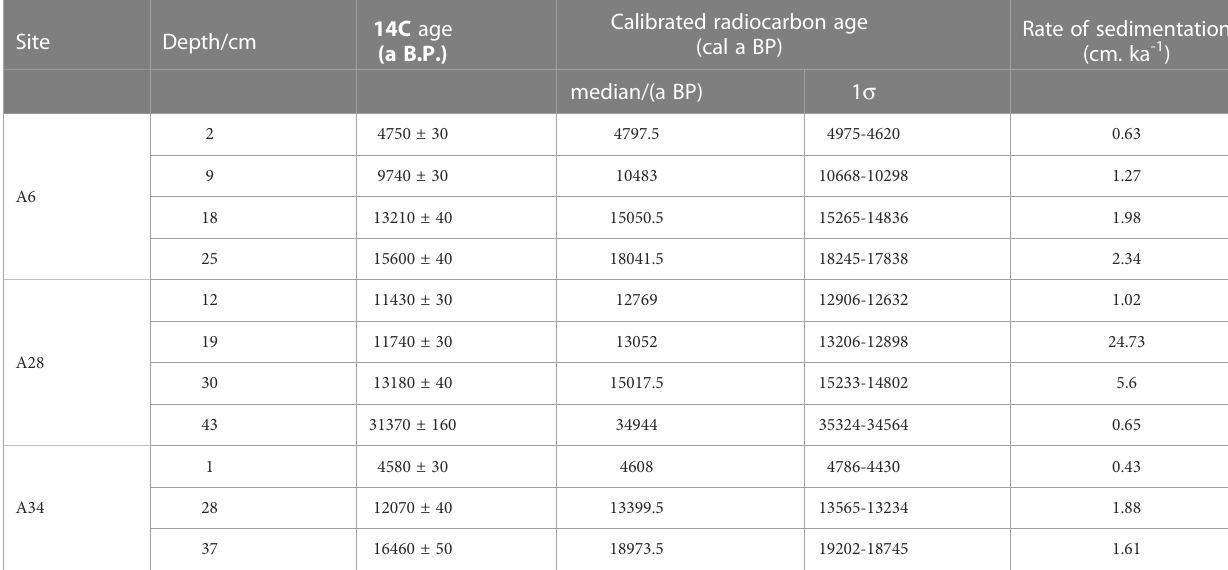
TABLE 3 AMS 14 C age data from A6, A28 and A34